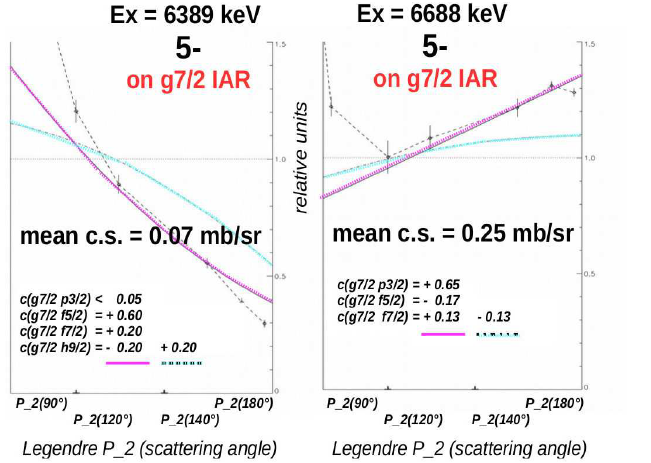
Figure 1. Angular distributions for 208 Pb( p , p ′ ) measured at the MPI-Heidelberg in 1969 using semiconductor detectors (12 keV resolution) at scattering angles 90 ◦ < Θ < 170 ◦ on the g 7 / 2 IAR in 209 Bi [8]. Calculations of the di ff erential cross section with known s.p. widths [7] yield up to four amplitudes for each state. The sensitivity is extremely high. The shown ampli- tudes − 1 < c ( LJ + 1 lj − 1 ) < + 1 for the configurations (left frame) g 7 / 2 p 3 / 2 , g 7 / 2 f 5 / 2 , g 7 / 2 f 7 / 2 , g 7 / 2 h 9 / 2 and (right frame) g 7 / 2 p 3 / 2 , g 7 / 2 f 5 / 2 , g 7 / 2 f 7 / 2 well reproduce the angular distribution at back- ward angles 140 ◦ < ∼ Θ ≤ 170 ◦ . Reversing the sign of one am- plitude as indicated does not yield a fit. Note that instead of the scattering angle Θ the Legendre polynomial P 2 ( Θ ) is used as ab- scissa.